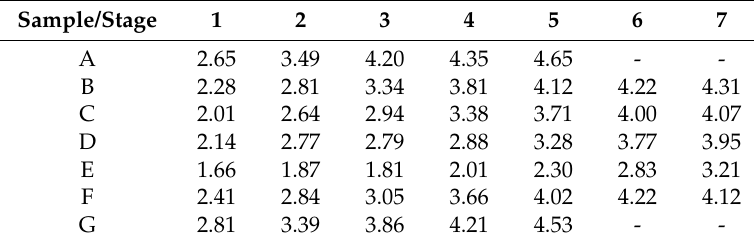
Table 2. Changes in NAG pH during the sequential NAG